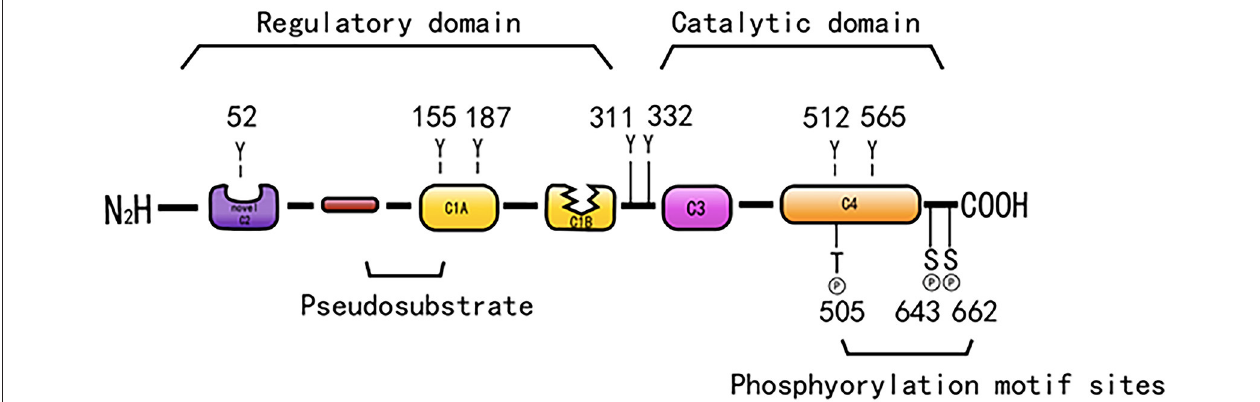
FIGURE 1 | The structure of PKC- δ . Schematic showing pseudo substrate (red rectangle), C1 domain (yellow rectangle), C2 domain (purple rectangle), C3 domain (pink rectangle), C4 domain (orange rectangle). The cyan represents the connecting hinge segment, the kinase region, and the gray rectangle represents the C-terminal tail. In particular, w switch in C1B domain determines the affinity of DAG containing membrane.